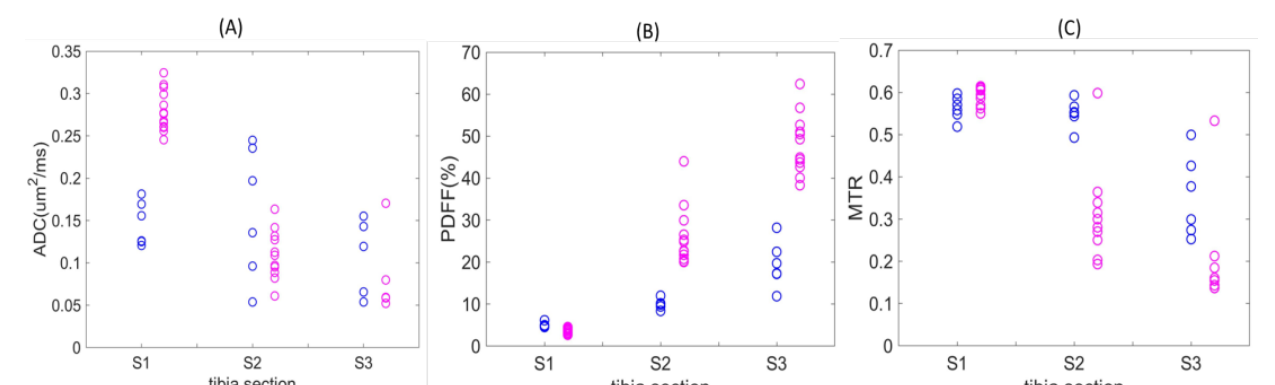
Table 2. Mean QIB values for WT mice and 5–6 weeks post-ablation for MF mice.